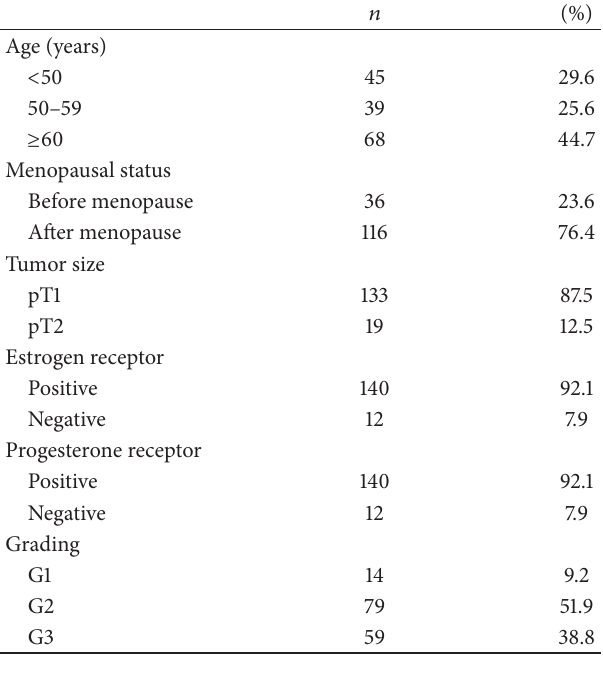
Table 1: Characteristics of the patients.